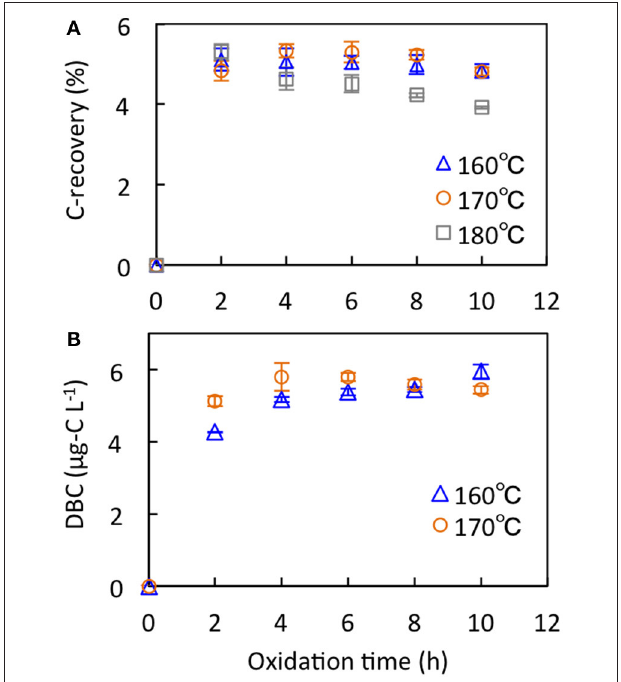
FIGURE 2 | BPCA carbon-based recoveries (C-recovery, %) of Suwannee River Humic Acid Standard II (SRHA) (A) and DBC concentration of deep seawater (B) after nitric oxidation under various temperatures and oxidation